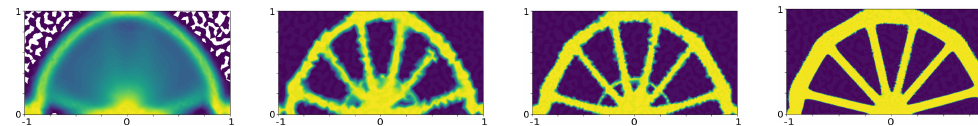
Figure A1. Iterations ϕ 100 , ϕ 200 , ϕ 300 , ϕ 538 from Algorithm A1.